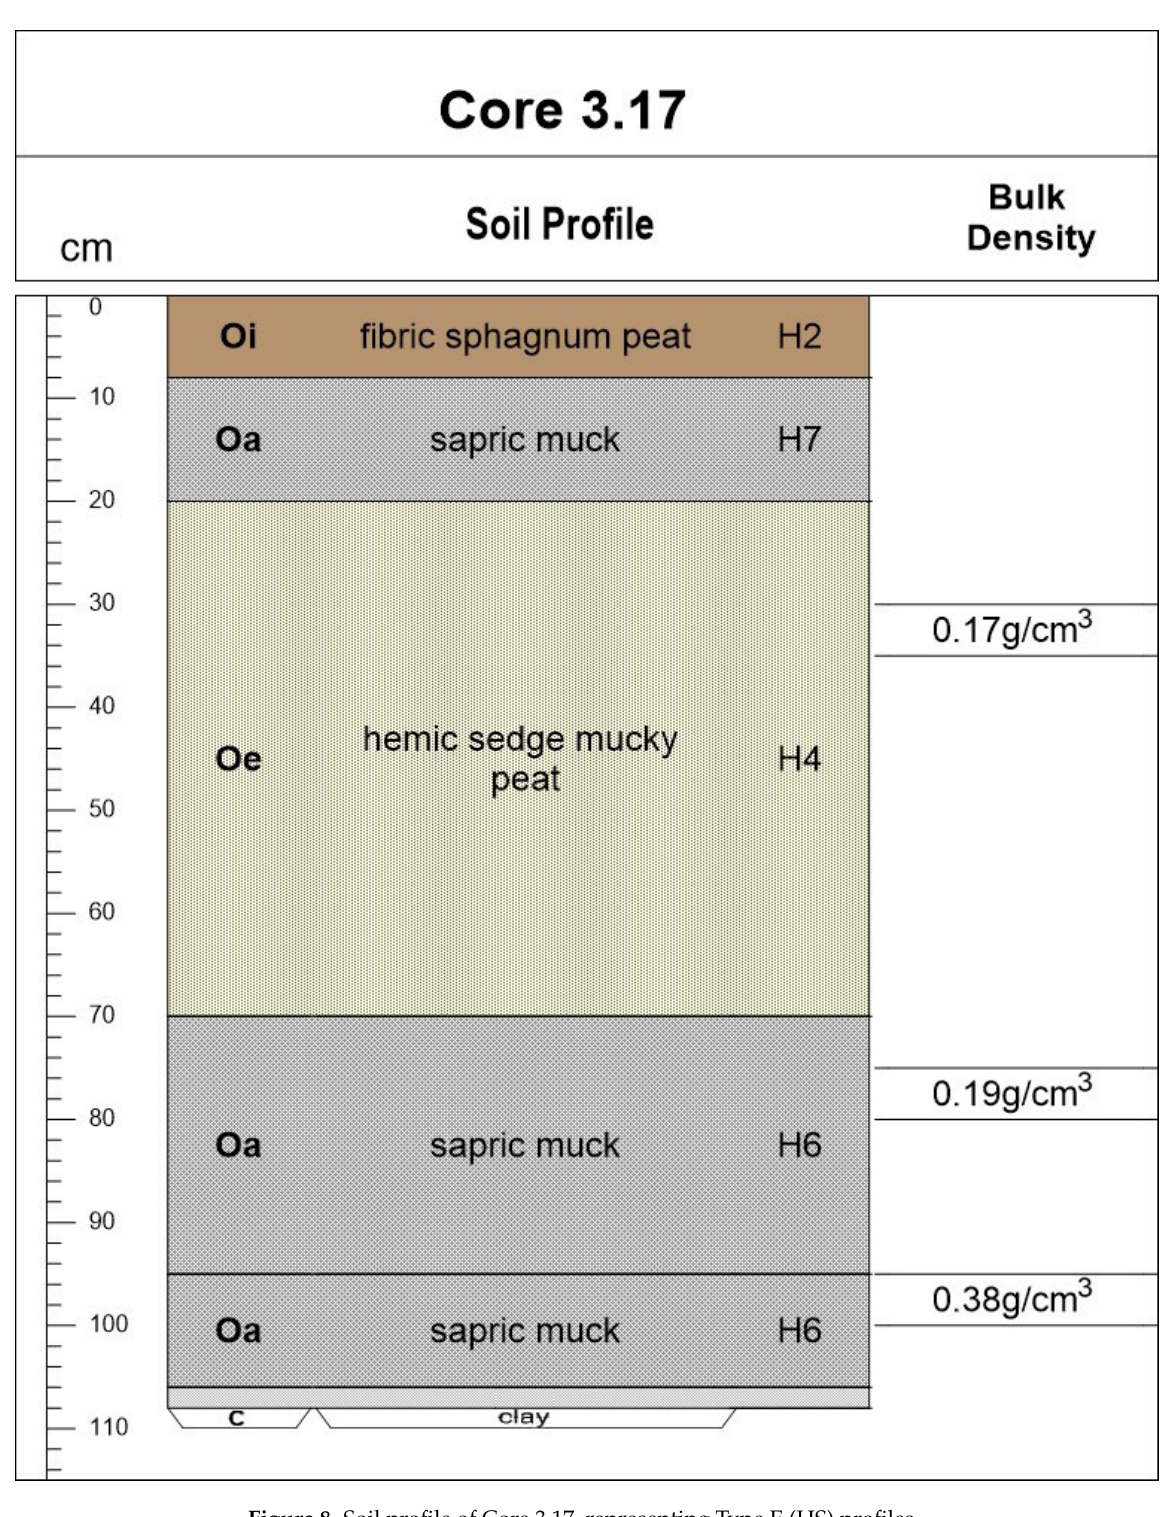
Figure 8. Soil profile of Core 3.17, representing Type E (HS) profiles.